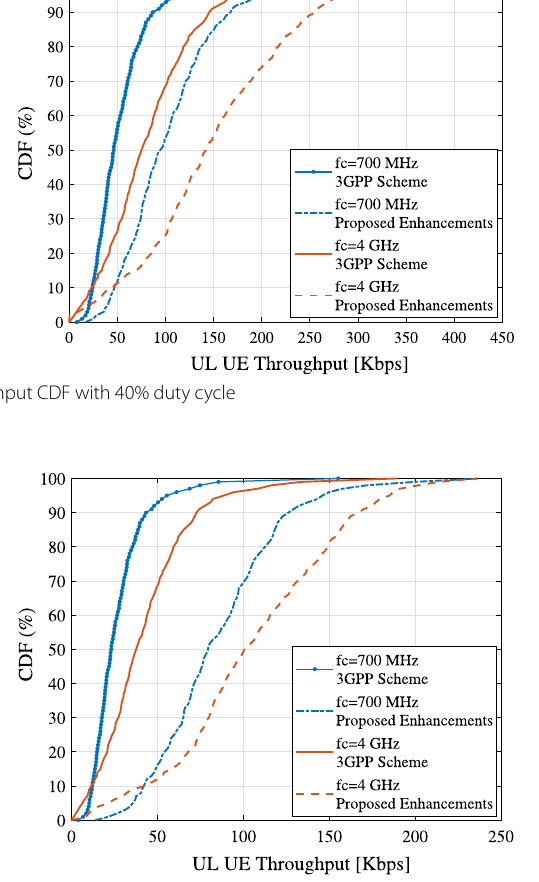
Fig. 14 User throughput CDF with 20% duty